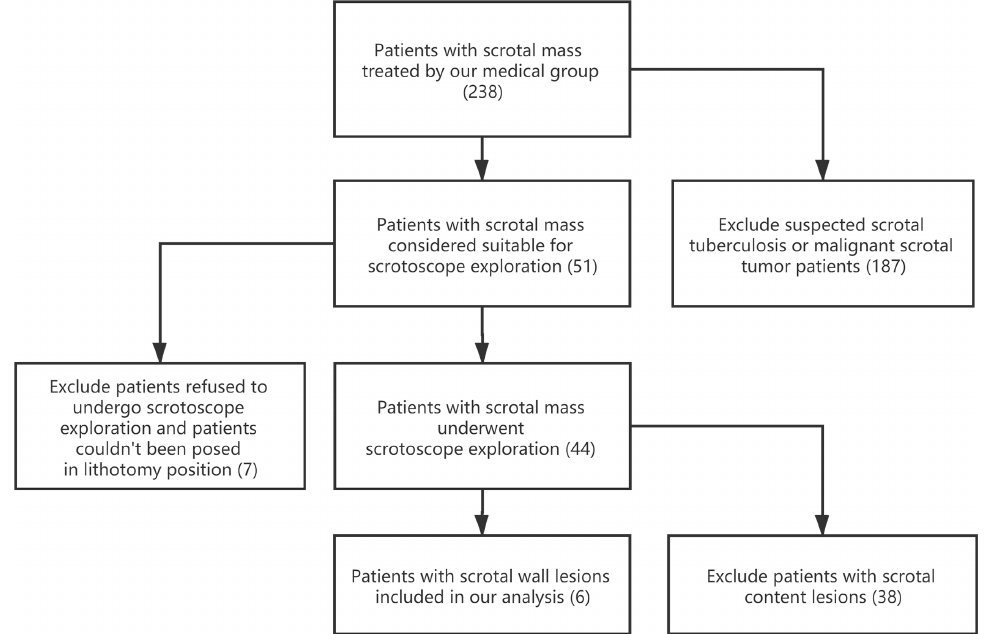
Fig. 2. Flow chart of the included